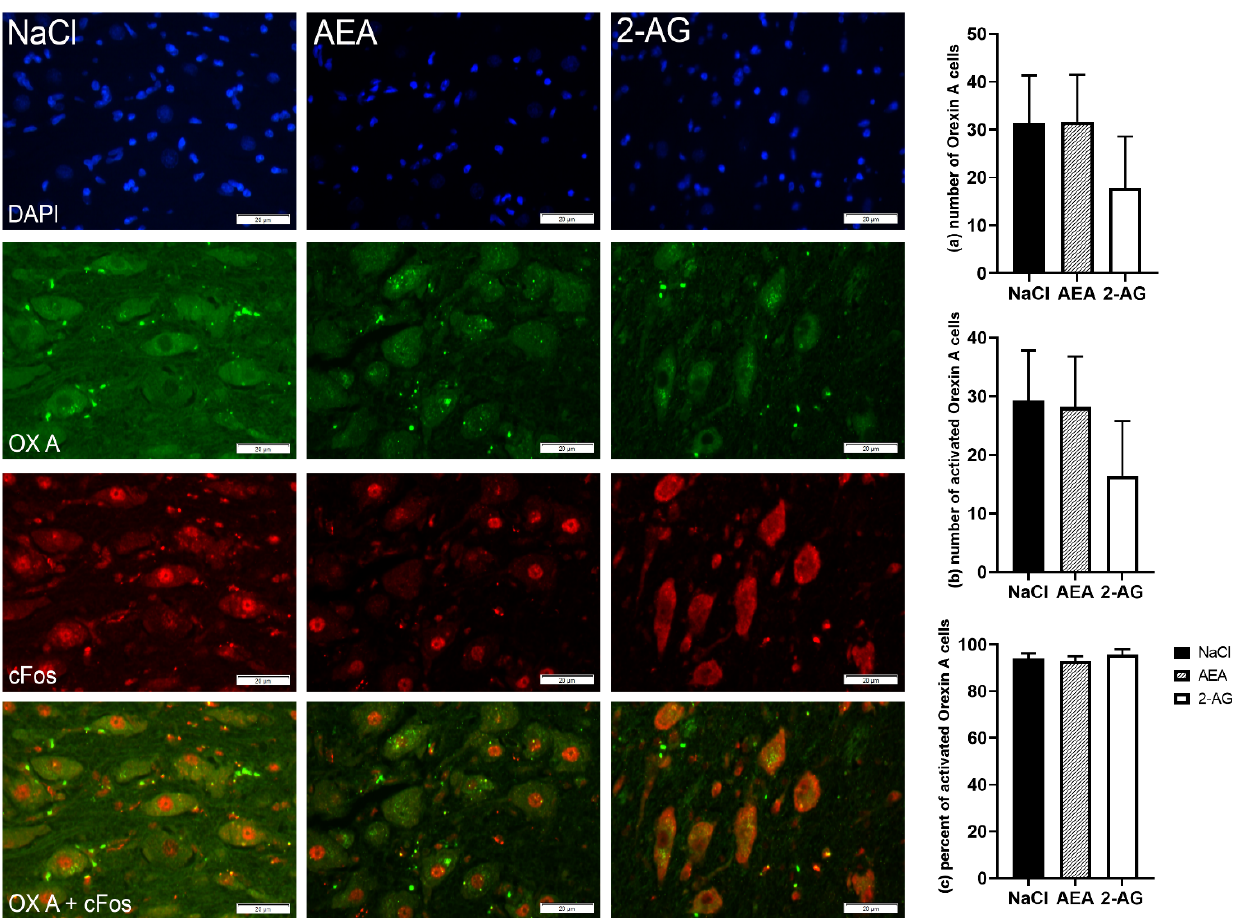
Figure 5. Immunofluorescence staining and representative images of the lateral hypothalamus (LH) of cows after intraperitoneal administration with NaCl ( n = 6), AEA ( n = 6) or 2-AG ( n = 5) for 9 days. DAPI-stained nuclei (blue), orexin-A neurons (green), cFos (red) and co-localization (merged image). Scale bar within images indicates 20 µm. Number of orexin-A neurons ( a ), number of cFos-positive orexin-A cells ( b ) and the percentage of activated orexin-A cells per total orexin-A cells ( c ). Data are shown as LSM ± SE with ( a ) F (2,14) = 0.58, p = 0.57, ( b ) F (2,14) = 0.61, p = 0.56, ( c ) F (2,13) = 0.45, p = 0.65 (ANOVA).